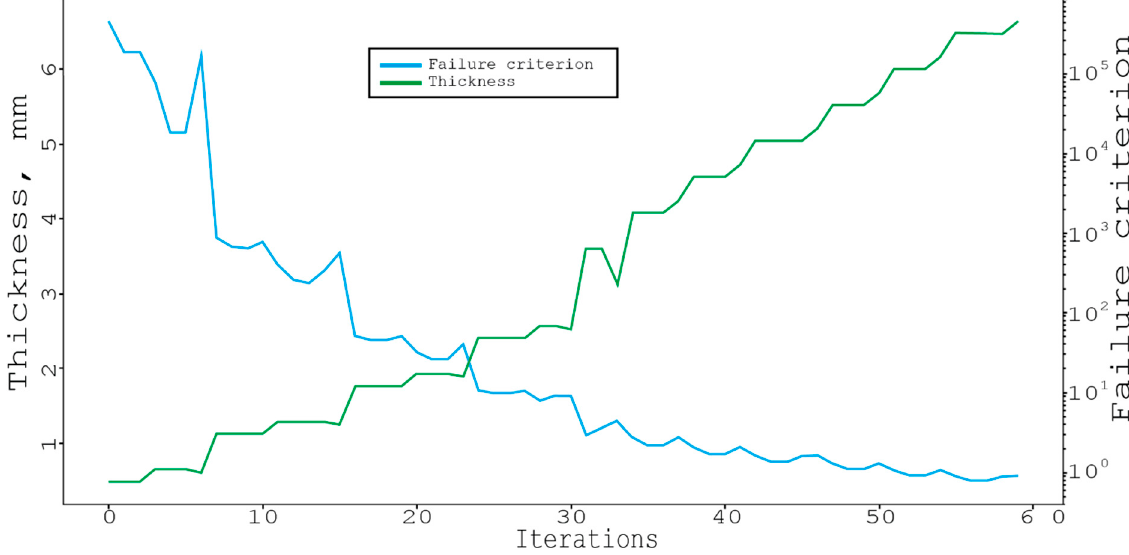
Figure 10. Local search through materials and angles with step of 15 deg, and a thickness = 6 mm 49.6 sec, failure criterion = 0.84.